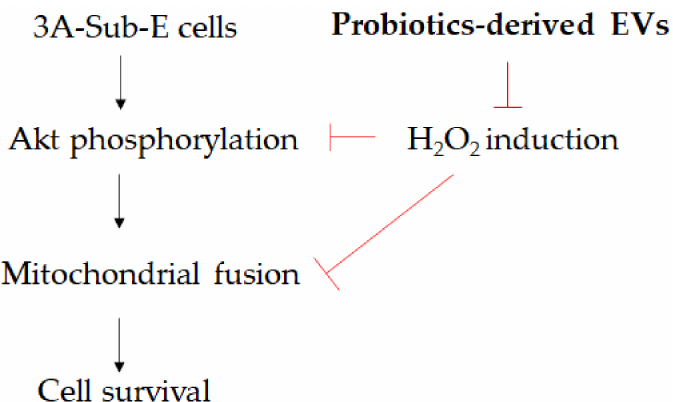
Figure 9. The potential of L. crispatus -derived EVs to protect against oxidative stress and senescence in t3A-sub-E placental cells exposed to H 2 O 2